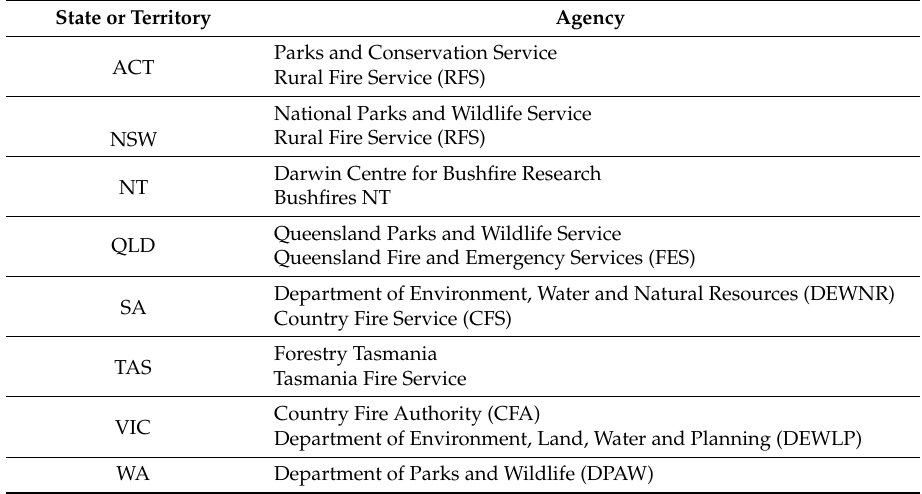
Table 1. List of fire management agencies in Australia that were approached in relation to the collection of data during